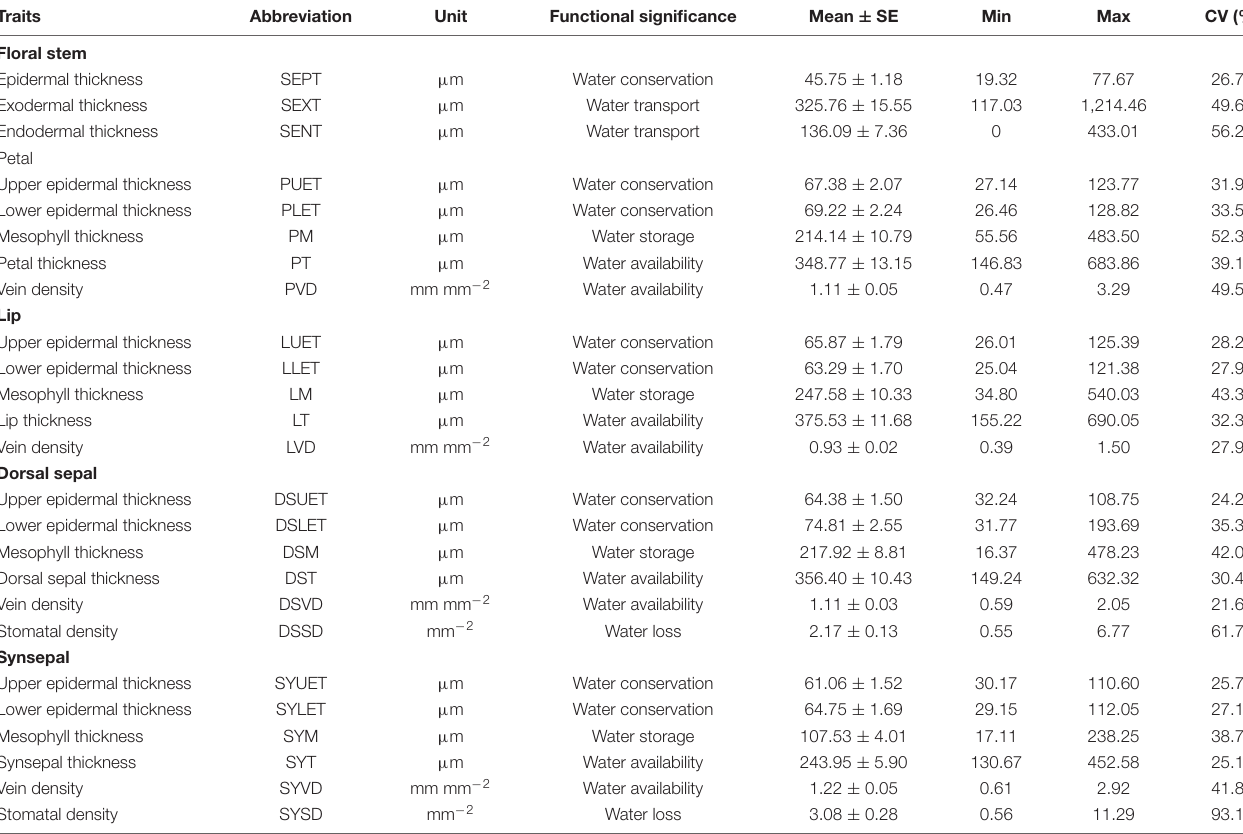
TABLE 1 | Quantification of floral structural traits for tested species.